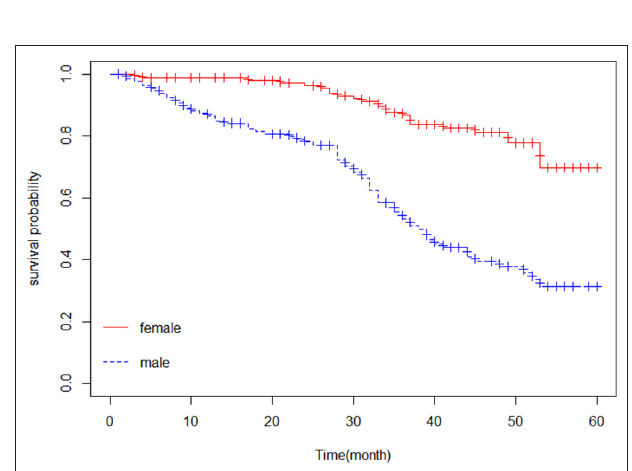
FIGURE 2 | Kaplan-Meier curve of chronic heart failure patients based on